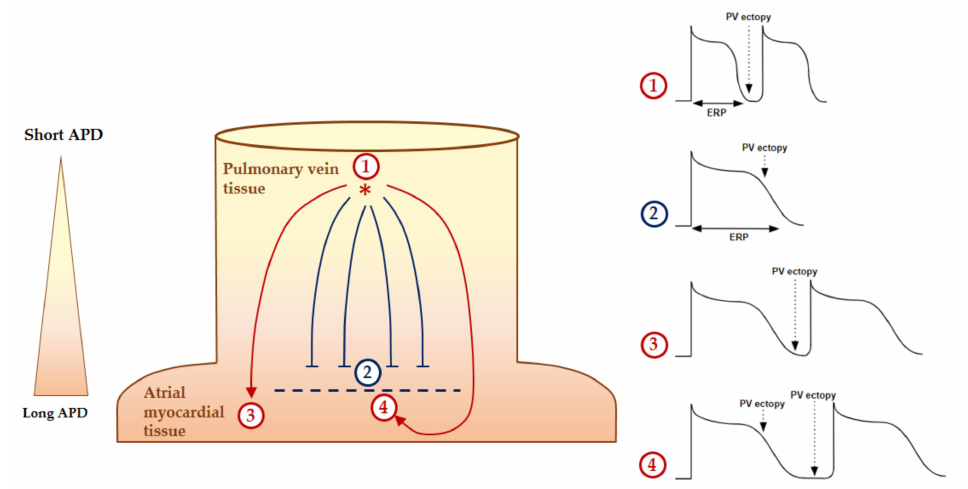
Figure 6. Formation of a functional reentrant circuit due to the heterogeneity of the atrial potential duration at the pulmonary vein (PV) entrance. The delay after depolarization in area no. 1 (cid:13) initiates a PV ectopy within the PV sleeve, where the action potential duration (APD) is shorter, with a subsequently shorter effective refractory period (ERP) and propagates toward the PV junction where the APD is longer. The ectopic beat blocks are in area no. 2 (cid:13) because of the refractory tissue. However, the impulse propagation continues laterally until the APD tissue is out of the refractory time (area no. 3 (cid:13) .). Finally, the PV ectopic beats move around the functional refractory area and then across the previous refractory region of the block in area no. 4 (cid:13) , which is now out of the refractory time. The dotted line represents the functional unidirectional refractory area, the solid arrows represent the propagation of the action potential and the star represents the initiation of the ectopic